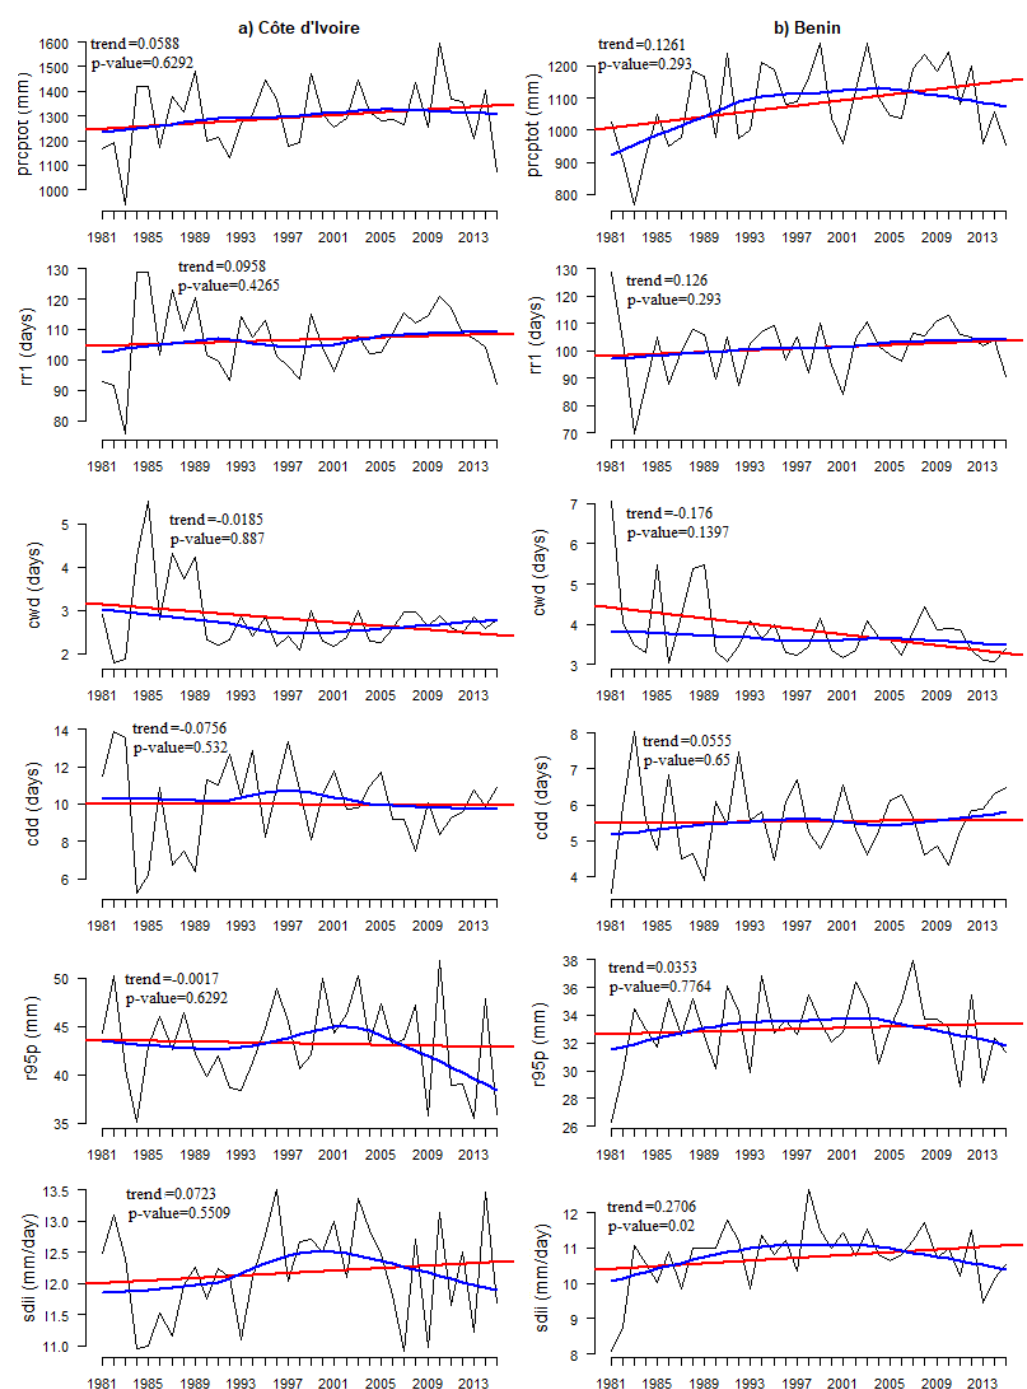
Figure 6. Time evolution of PRCPTOT (mm), RR1 (days), CWD (days), CDD (days), R95P (mm), and SDII (mm/day), averaged over a) Côte d’Ivoire and b) Benin. The red line corresponds to the linear regression in the time series (1981–2015) and the blue curve corresponds to the best fit of the weighted least squares, shown as the best line with the minimal distance from the data.